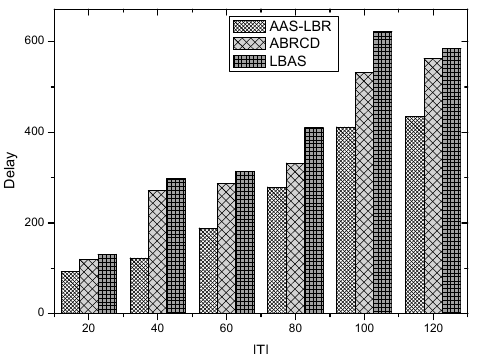
Figure 48. The impact of | T | with fixed network nodes = 600 with fixed on the delay.